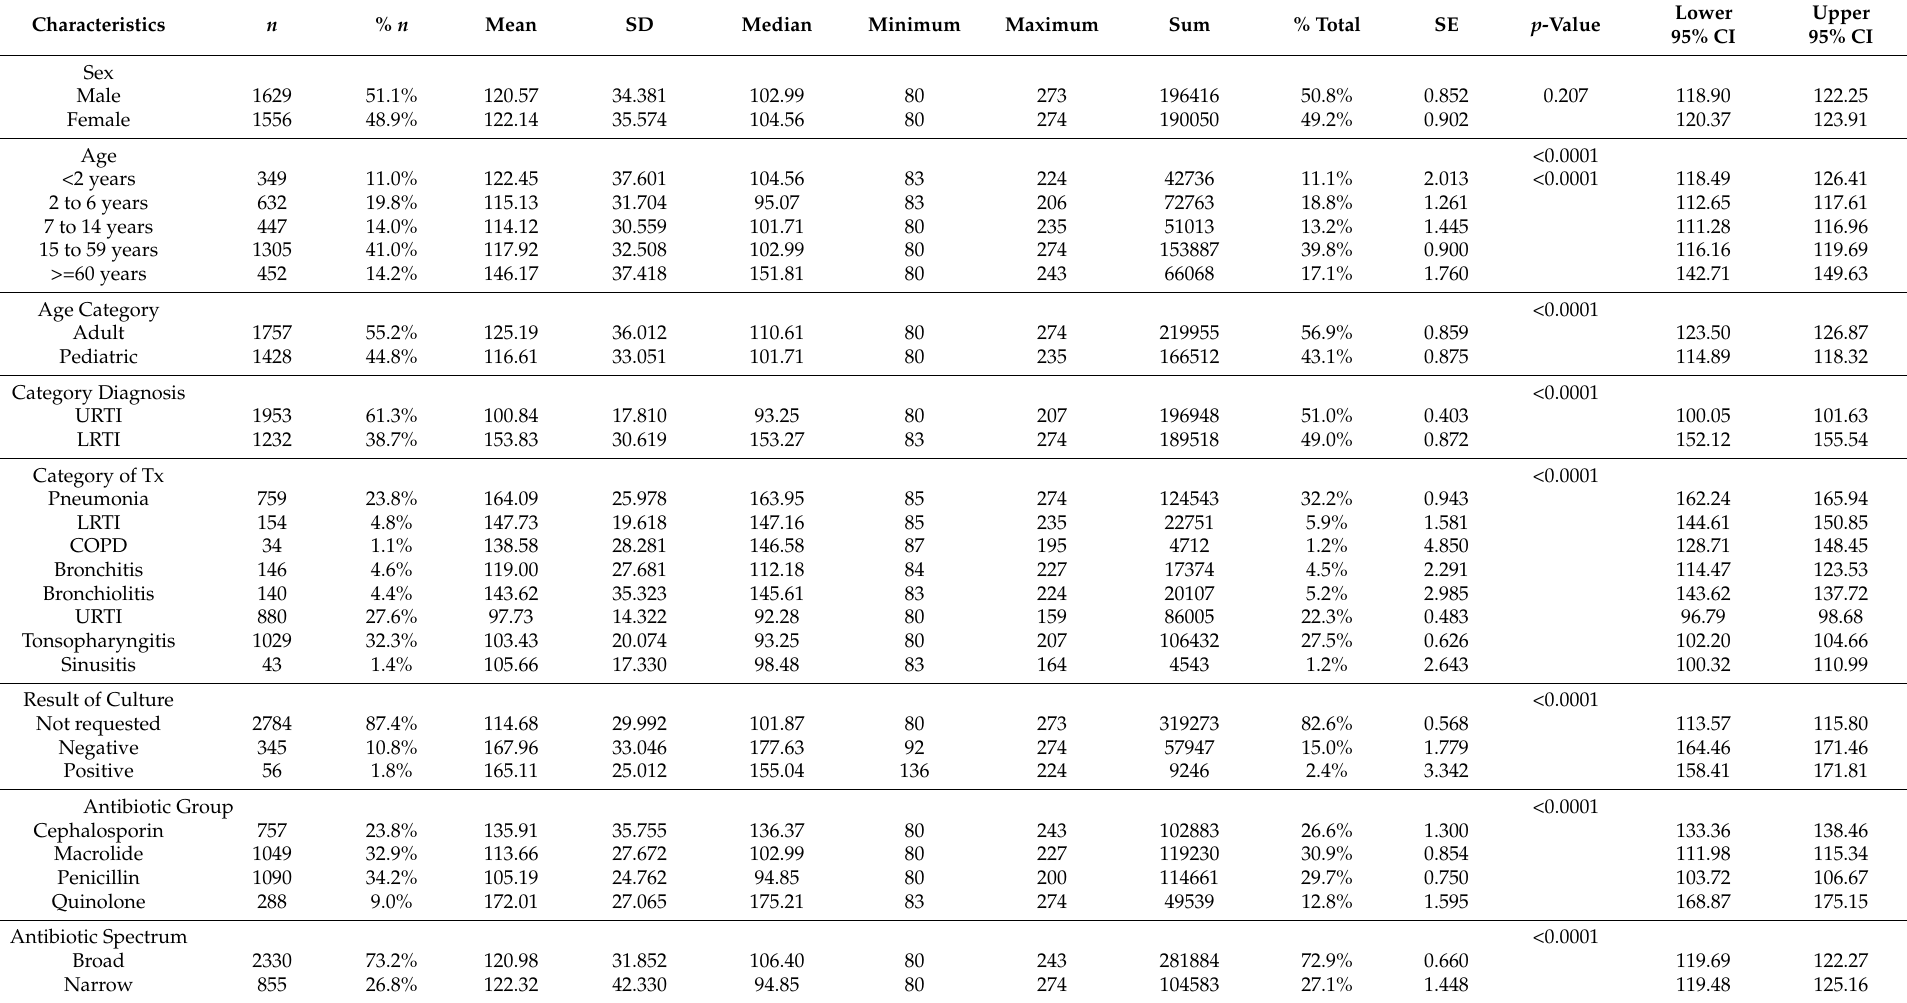
Table 4. Total cost of treatment for respiratory tract